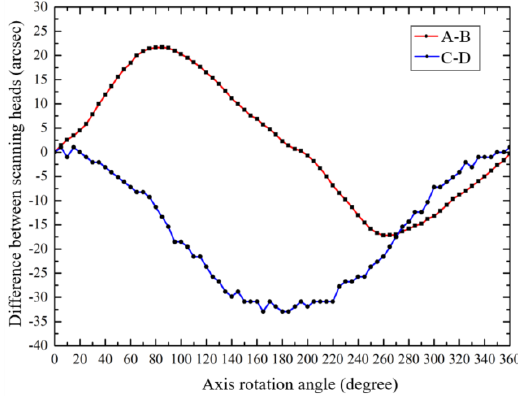
Figure 9. The differences between the indications of the different scanning heads. Figure 9. The di ff erences between the indications of the di ff erent scanning heads.